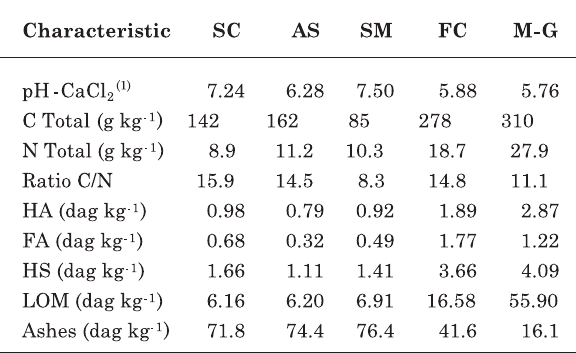
Table 2. Chemical characterization of composts developed from different materials and enriched with minerals